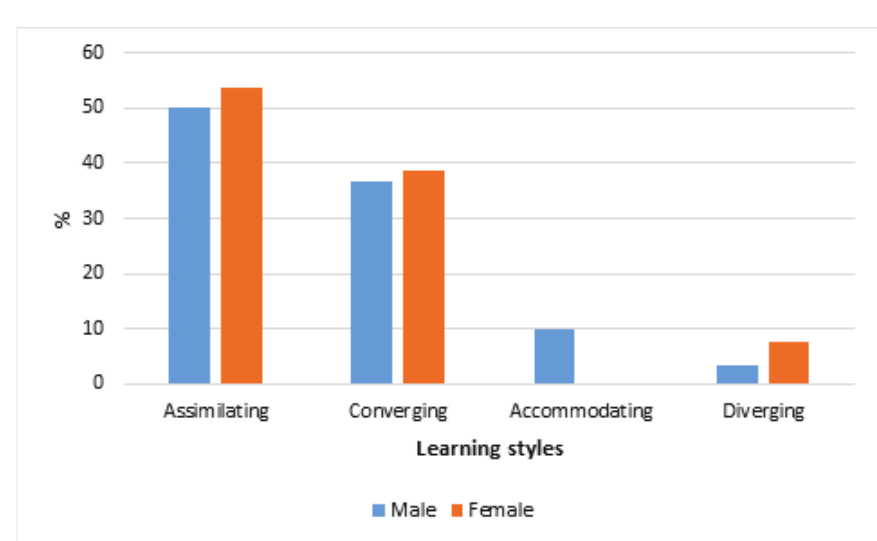
Figure 1. The experiential Kolb’s learning cycle.